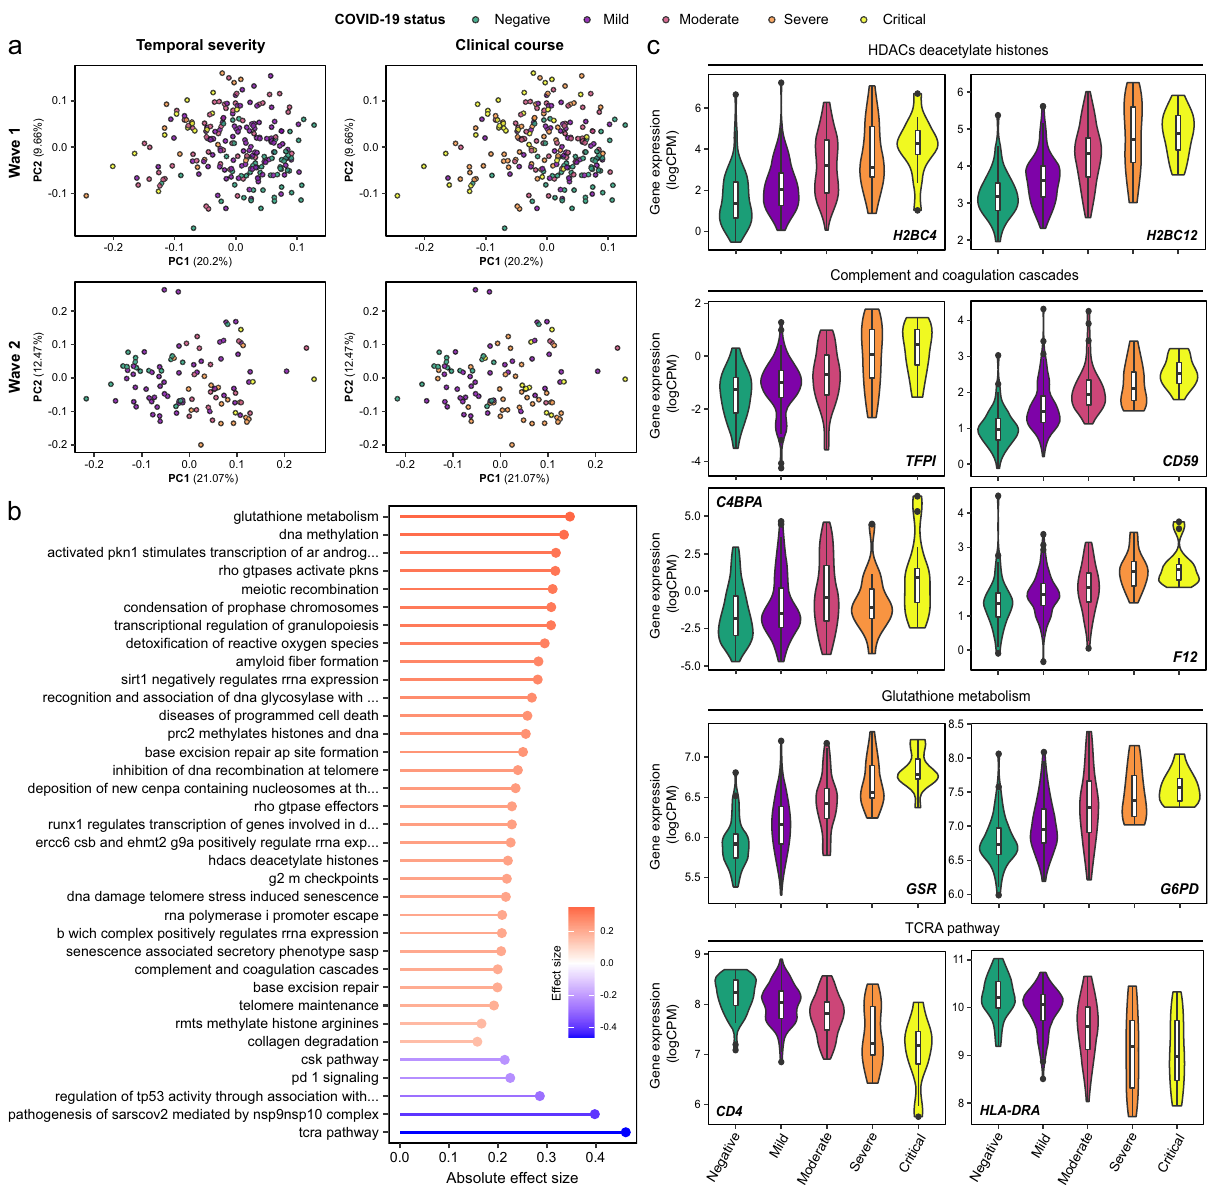
Fig.3|AssociationofthePBMCtranscriptomeandCOVID-19severity.a PCAof the PBMC transcriptome. Each point represents a sample and is coloured by con- temporaneous COVID-19 WHO severity (left) and overall clinical course (right). b The 30 GSVA transcriptomic pathway enrichment terms with the greatest RRA scores.Allweresigni fi cantlyenrichedinbothWave1and2cohorts(1%FDR).Terms are ordered and coloured by their effect size. Red=up-regulated in more severe COVID-19;blue=down-regulated. c Violinplotsshowgeneexpressionvalues(Wave 1 cohort; n =179 samples from 51 COVID-19 positive ESKD patients and 55 samples from COVID-19 negative ESKD patients) strati fi ed by COVID-19 status and severity